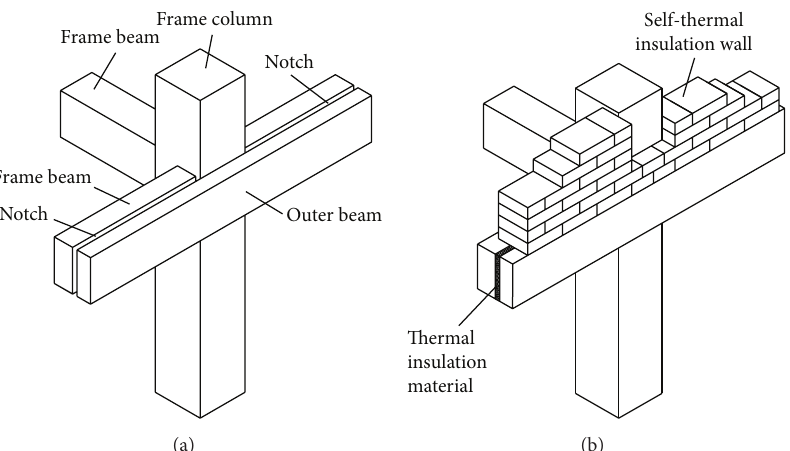
Figure 1: Sketch of energy conservation slotted beam-wall system: (a) constructional details of the slotted beam and (b) the view after self- thermal insulation wall